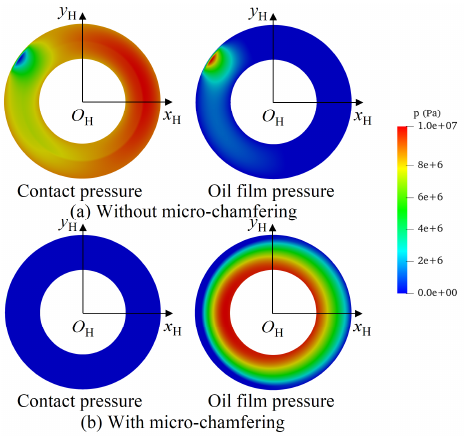
Figure 10. Pressure distribution of slipper bottom at shaft angle of 90°.